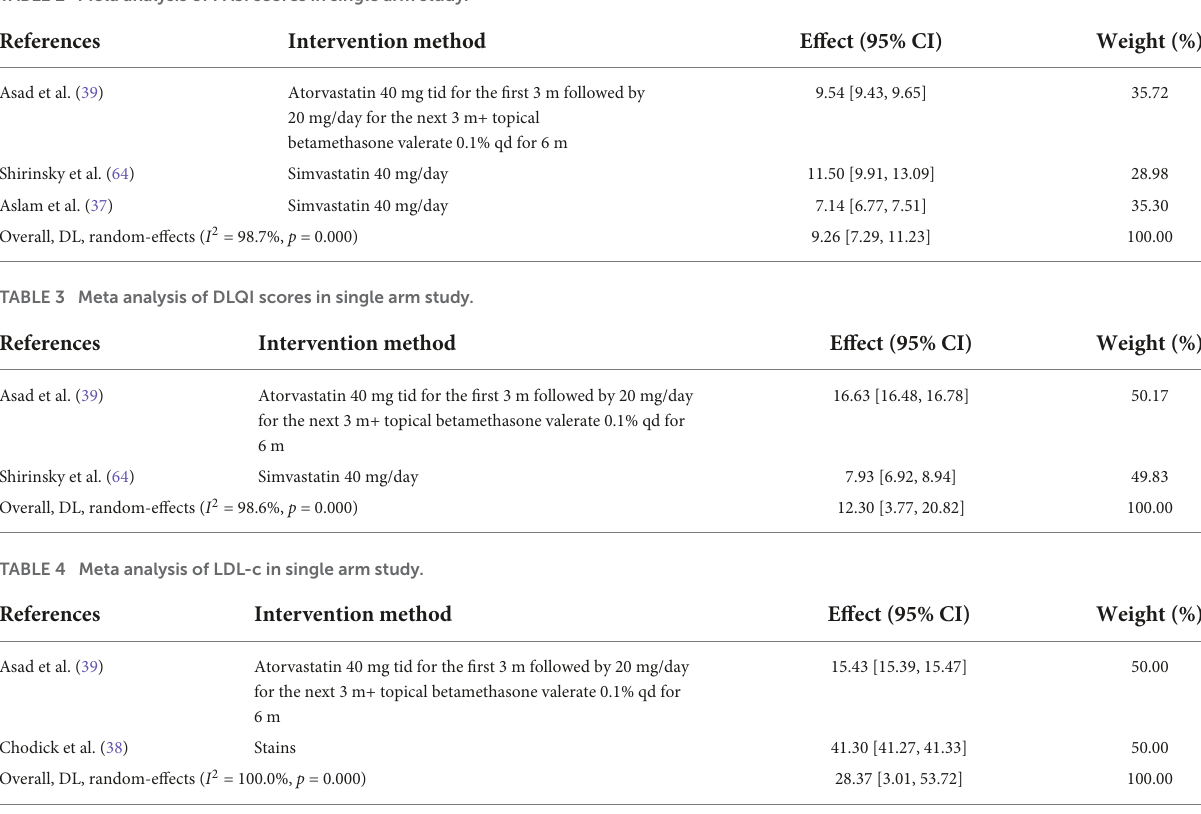
TABLE 2 Meta analysis of PASI scores in single arm study.